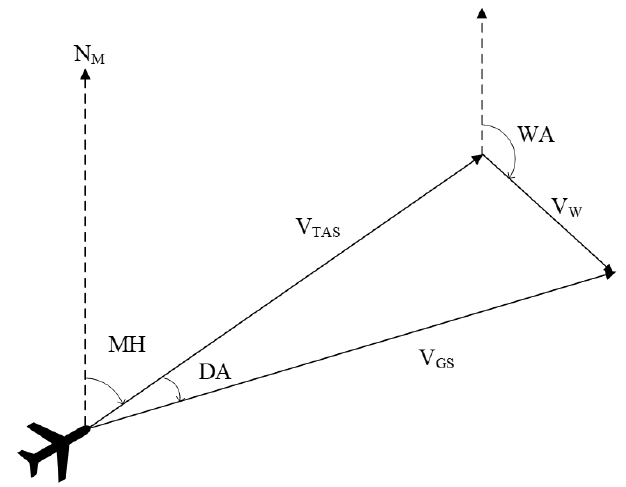
Figure 1. Aircraft speed triangle. Table 1. Notations and their corresponding concepts of Figure